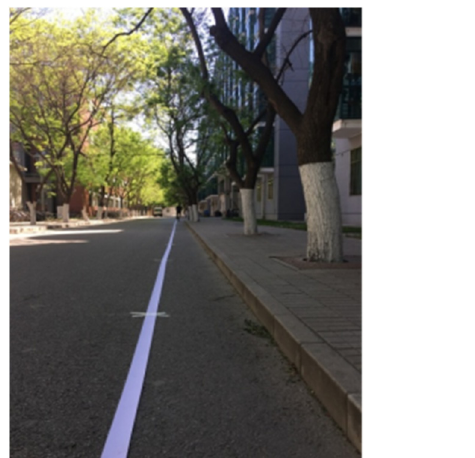
Table 3. Basic cycling widths in the guidelines of various countries or regions.